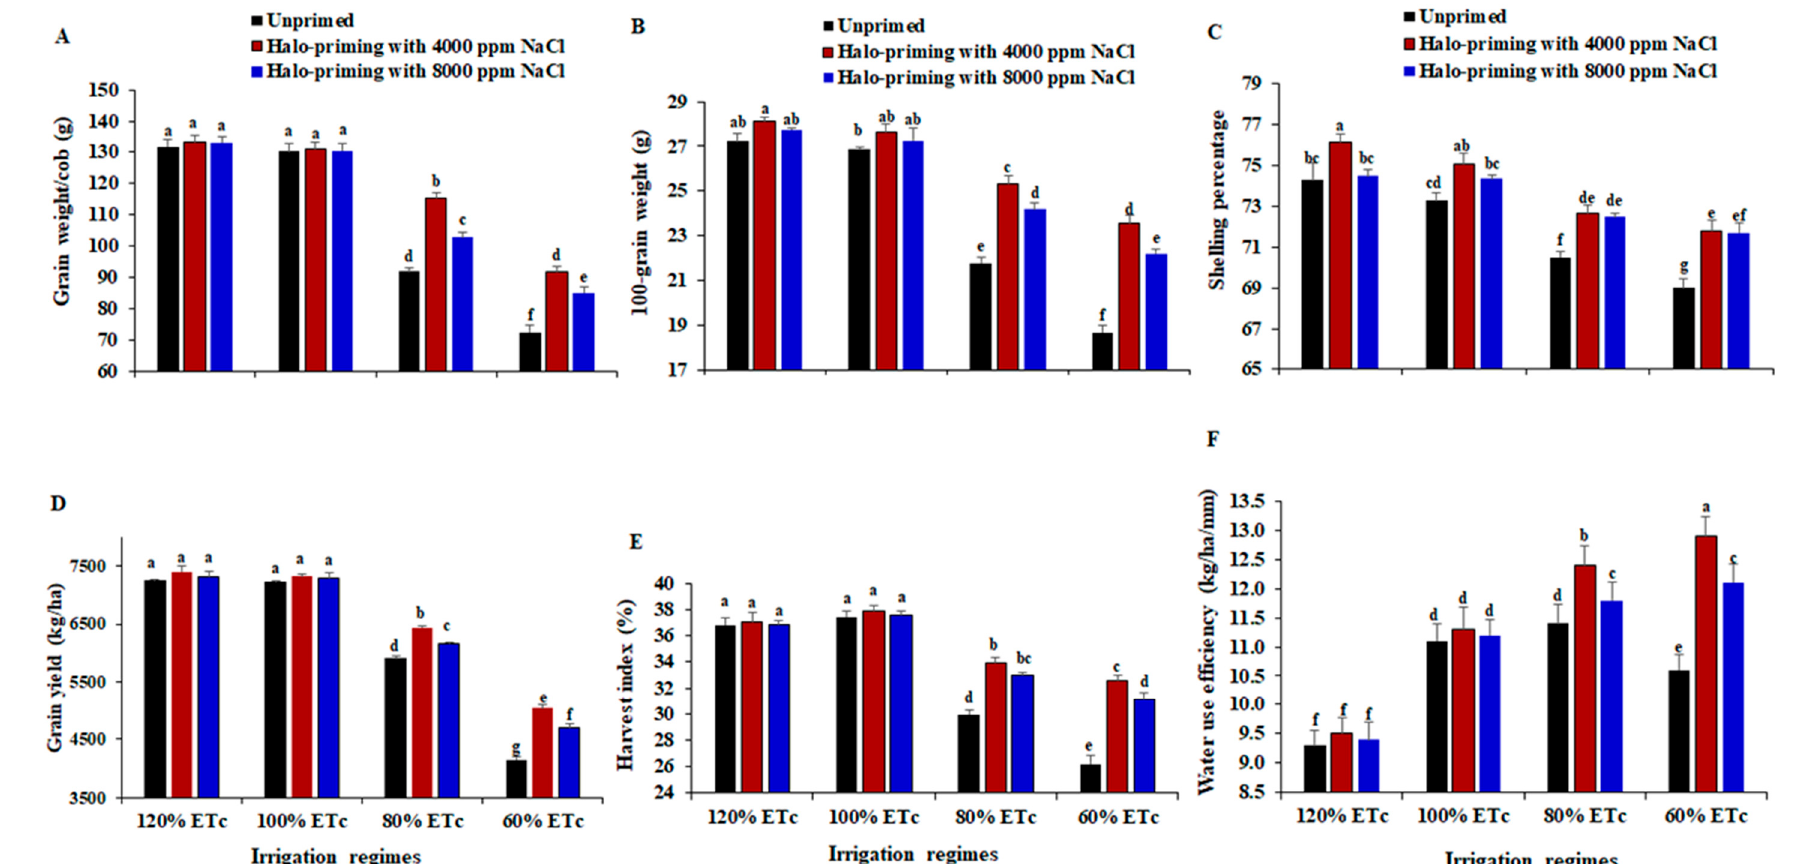
Figure 3. Impact of seed halo-priming treatments on grain weight cob − 1 ( A ), 100-grain weight ( B ), shelling percentage ( C ), grain yield ( D ), harvest index ( E ), and water use efficiency ( F ) of maize under four irrigation regimes over two seasons 2018 and 2019. The bars on the columns correspond to SE and different letters differ significantly by LSD (P < 0.05).